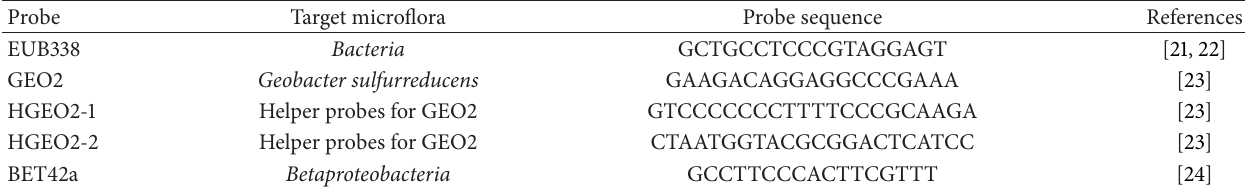
Table 1: Probe name and probe sequence used for FISH